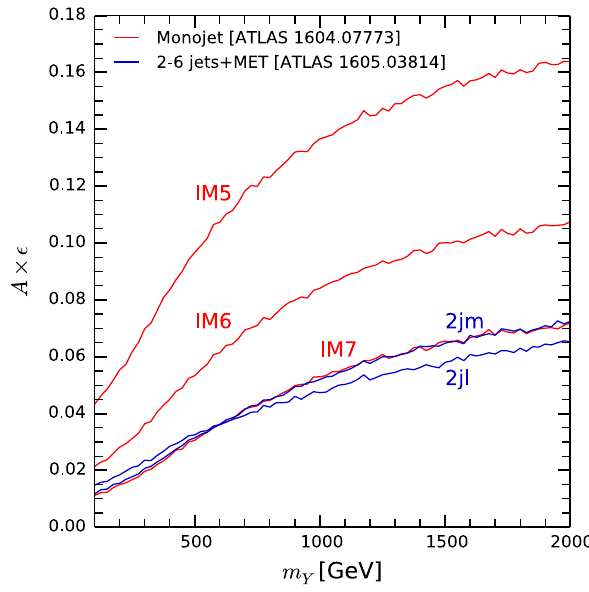
Fig. 11 Signal acceptance times efficiency, A × (cid:15) , as a function of the mediator mass for the most relevant SRs, i.e. IM5, IM6 and IM7 of the ATLAS monojet search [5] and 2jl and 2jm of the ATLAS 2–6 jets + / E CheckMATE2 T search [43], evaluated with